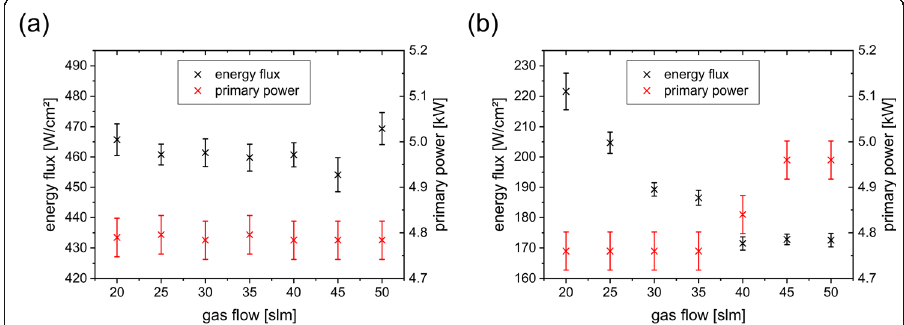
Fig. 4 a Influence of the gas flow on the energy flux ( a ) for nozzle head A and ( b ) for nozzle head B. These measurements were performed with a primary voltage of 400 V and at a probe distance of 4 mm to the nozzle head